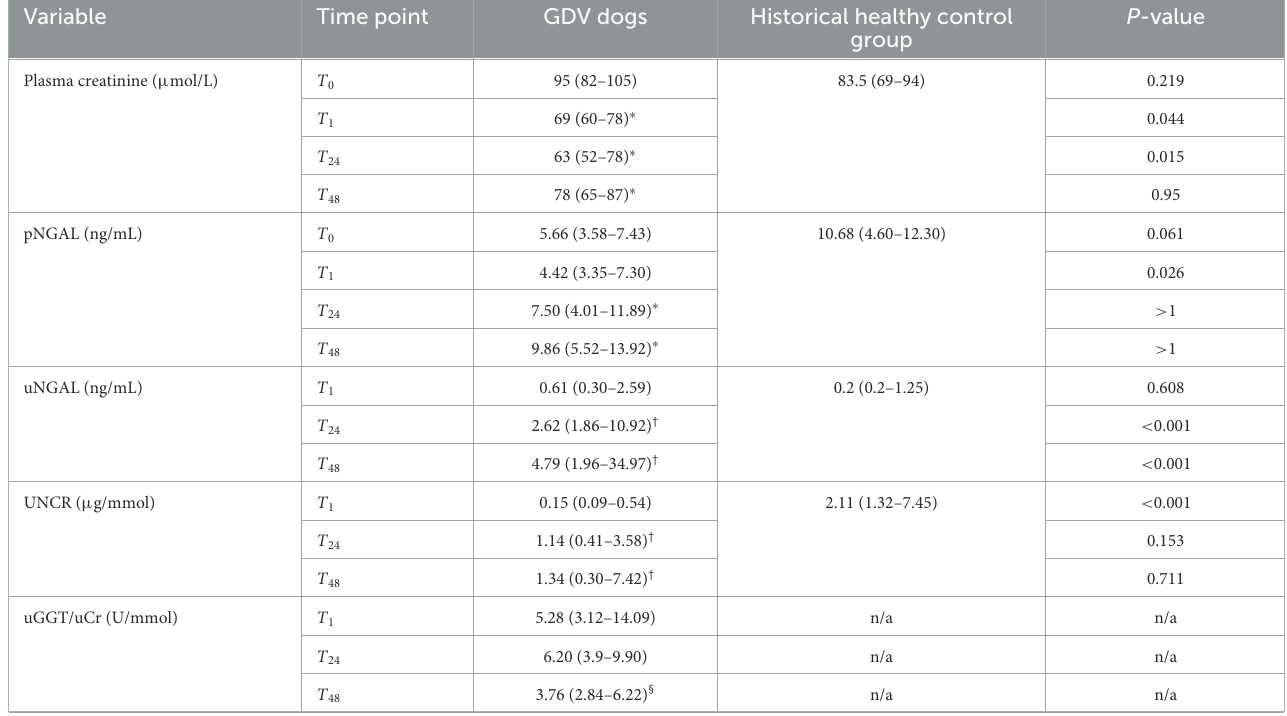
TABLE 3 Median (IQR) of plasma and urinary renal markers in dogs with GDV and 18 healthy control dogs. Variable Time point GDV dogs Historical healthy control